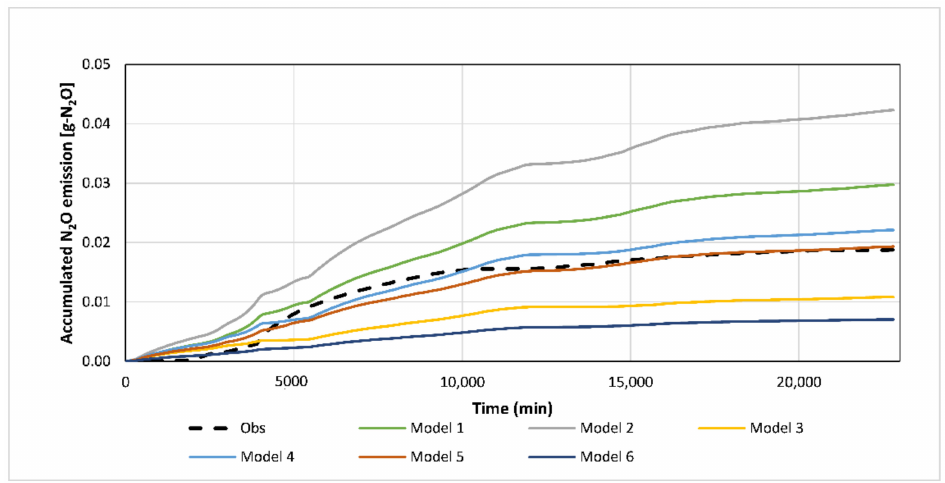
Figure 11. Experiment 2: temporal progression of the simulated cumulative N 2 O emissions for each of the soil gas diffusivity models with the observed